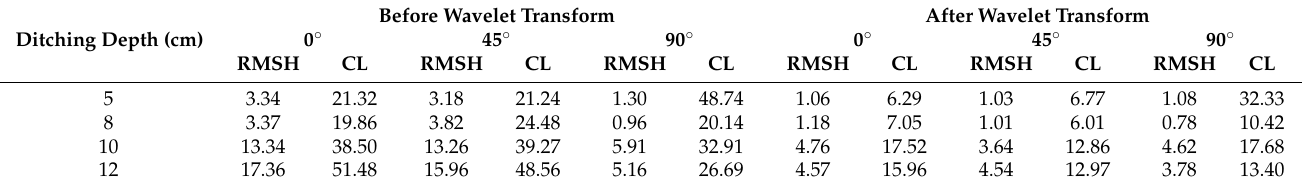
Table 3. The RMSH and CL values of cross-sections in different directions before and after wavelet